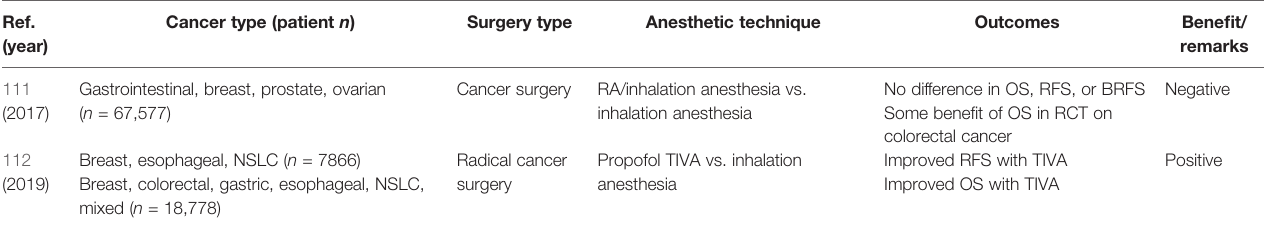
TABLE 2 | Meta-analyses of anesthetic technique and breast cancer recurrence. Ref.